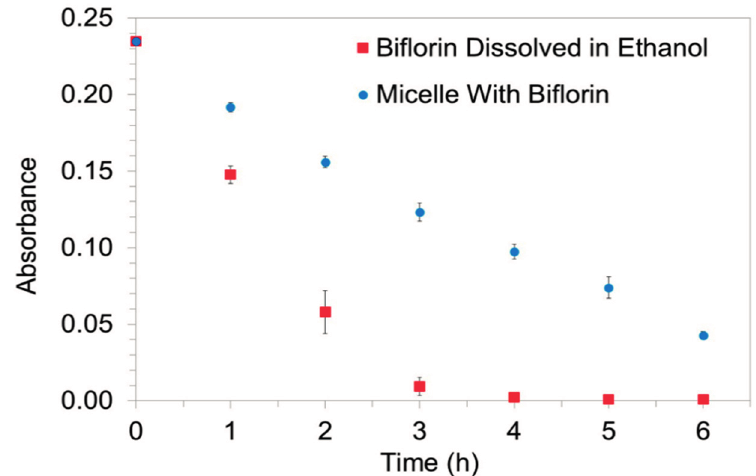
Figure 3. Biflorin micellar nanostructure (blue dots) and biflorin in ethanol (red squares), absorbance at 555 nm evaluated in function of the exposure time in a photostability chamber. Error bars represents standard